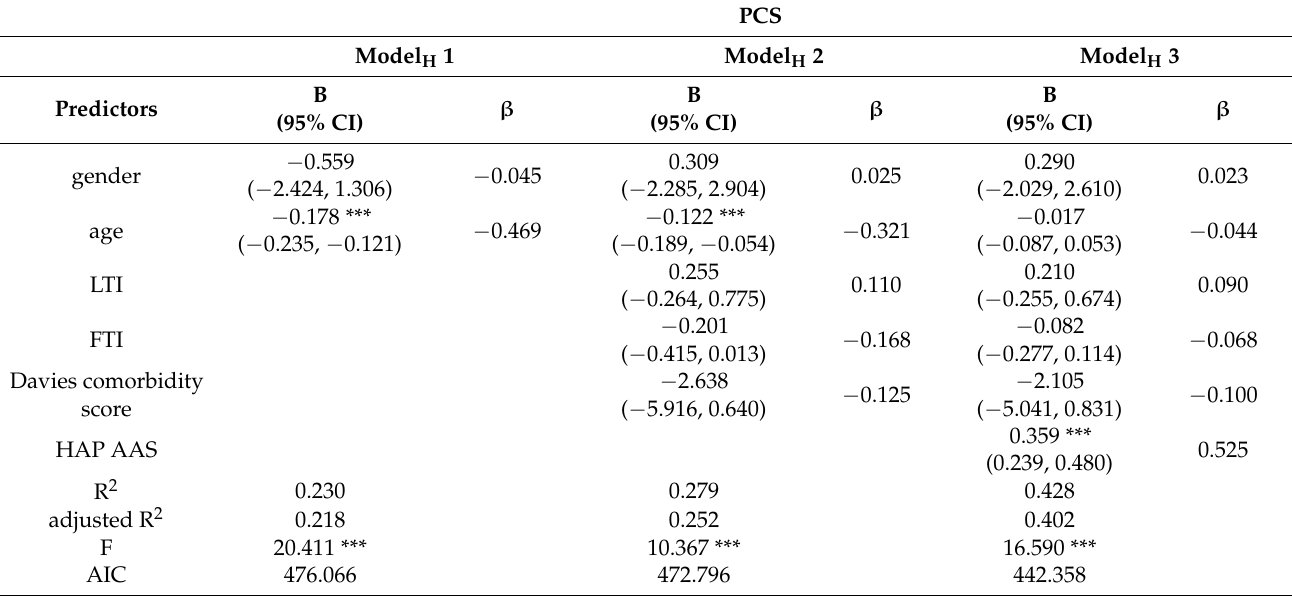
Table 5. Hierarchical multiple linear regression models of PCS ( n =